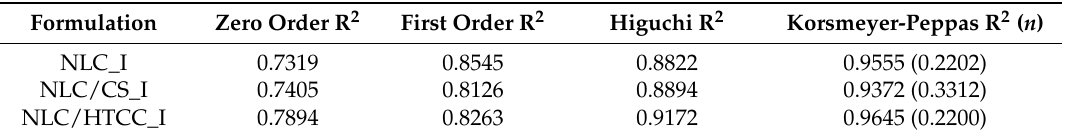
Table 4. Regression coefficient (R 2 ) and release exponent (n) values calculated using the non-linear regression models for in vitro release profiles of indomethacin loaded NLC formulations.